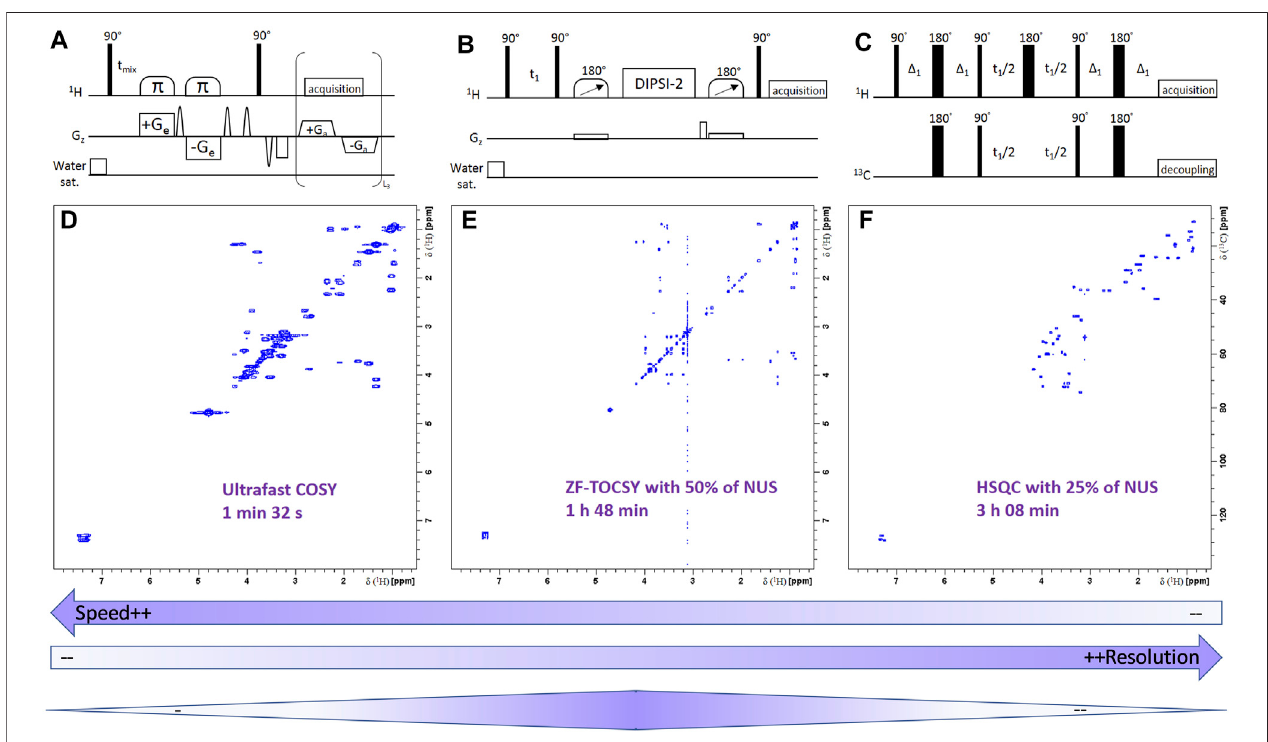
FIGURE 7 | Typical fast 2D NMR pulse sequences for high-throughput metabolomics and their corresponding spectrum obtained on a model mixture of metabolites (A,D) Ultrafast 1 H – 1 H correlation spectroscopy (UF COS)Y (B,E) Z- fi lter 1 H – 1 H total correlation spectroscopy (ZF-TOCSY) with 50% of non-uniform sampling in the indirect dimension (C,F) 1 H – 13 C heteronuclear single-quantum correlation (HSQC) with 25% of non-uniform sampling in the indirect dimension. Pulse sequences offer complementary performances in terms of speed, resolution and sensitivity. Adapted with permission from (Martineau et al.,